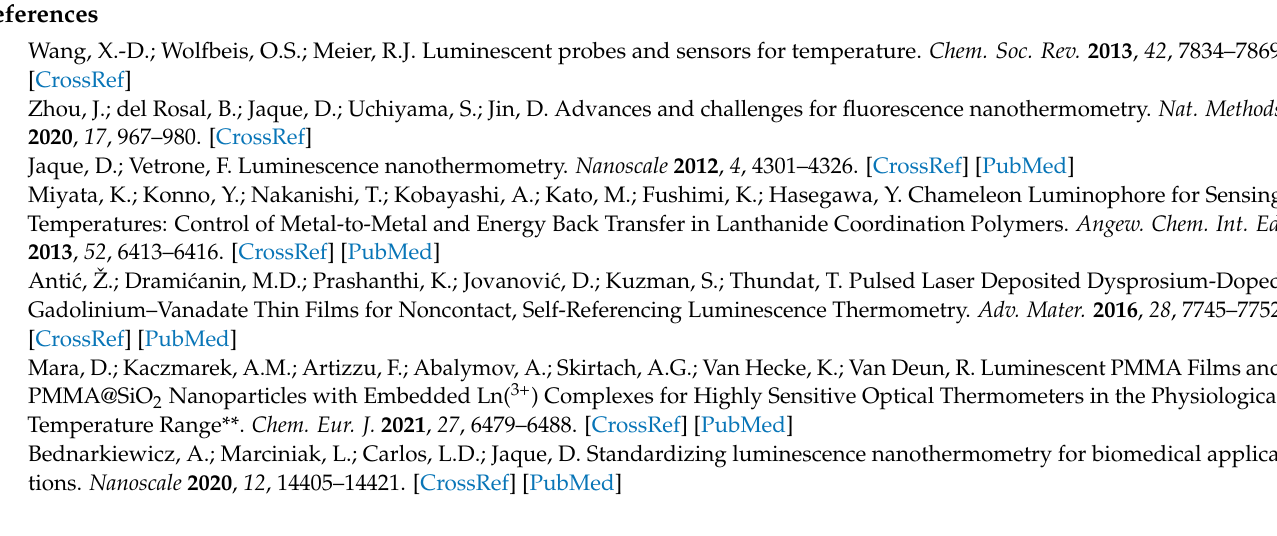
spectra and the shift in wavelength corresponding to the maximum fluorescence emission intensity); Figure S9: Temperature-dependent fluorescent emission spectra, fluorescence intensity at 621 nm of Zn-CYMPN ⊃ DPEE-3 and the fitting line with temperature of 50~200 ◦ C, the relative sensitivity for intensity, wavelength at the maximum fluorescent emission of Zn-CYMPN ⊃ DPEE-3 and the fitting line with temperature of 40~250 ◦ C (insert: temperature-dependent fluorescent emission spectra and the shift in wavelength corresponding to the maximum fluorescence emission intensity); Figure S10: Temperature-dependent fluorescent emission spectra, fluorescence intensity at 616 nm of Zn-CYMPN ⊃ DPEM-1 and the fitting line with temperature of 100~250 ◦ C, the relative sensitivity for intensity, wavelength at the maximum fluorescent emission of Zn-CYMPN ⊃ DPEM-1 and the fitting line with temperature of 40~250 ◦ C (insert: temperature-dependent fluorescent emission spectra and the shift in wavelength corresponding to the maximum fluorescence emission intensity); Figure S11: Temperature-dependent fluorescent emission spectra, fluorescence intensity at 614 nm of Zn-CYMPN ⊃ DPEM-2 and the fitting line with temperature of 100~250 ◦ C, the relative sensitivity for intensity, wavelength at the maximum fluorescent emission of Zn-CYMPN ⊃ DPEM-2 and the fitting line with temperature of 40~250 ◦ C (insert: temperature-dependent fluorescent emission spectra and the shift in wavelength corresponding to the maximum fluorescence emission intensity); Figure S12: Temperature-dependent fluorescent emission spectra, fluorescence intensity at 610 nm of Zn-CYMPN ⊃ DPEM-3 and the fitting line with temperature of 100~250 ◦ C, the relative sensitivity for intensity, wavelength at the maximum fluorescent emission of Zn-CYMPN ⊃ DPEM-3 and the fitting line with temperature of 40~250 ◦ C (insert: temperature-dependent fluorescent emission spectra and the shift in wavelength corresponding to the maximum fluorescence emission intensity); Figure S13: The optical photographs of Zn-CYMPN before (left) and after (right) being encapsulated with DPEE with excitation using a 380 nm mercury